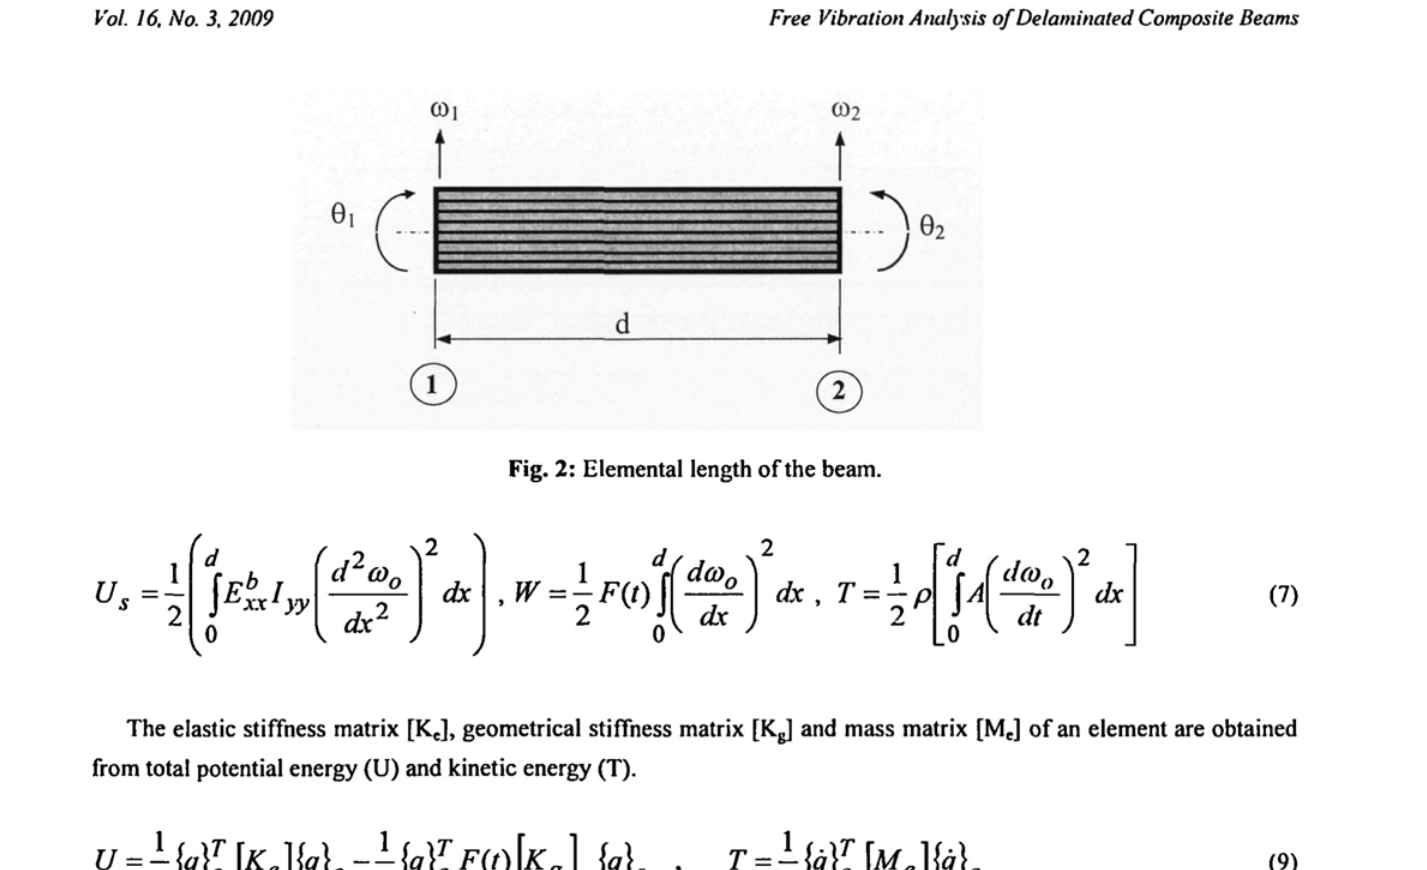
Fig. 2: Elemental length of the